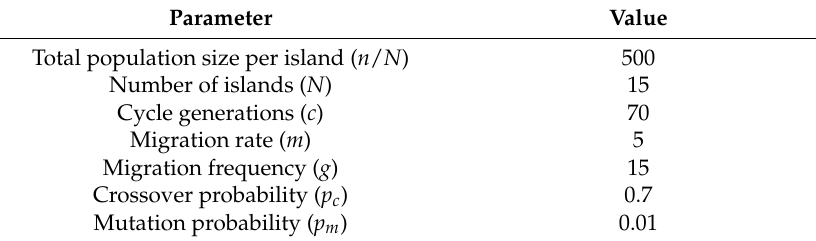
Table 4. Settings of the parameters in our